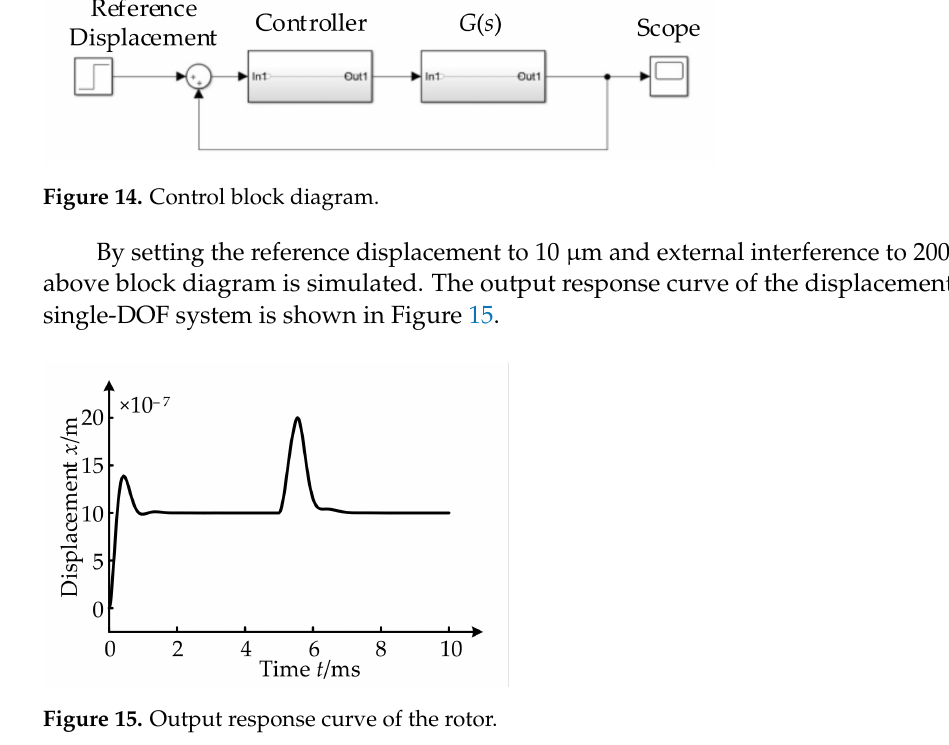
Figure 14. Control block diagram.